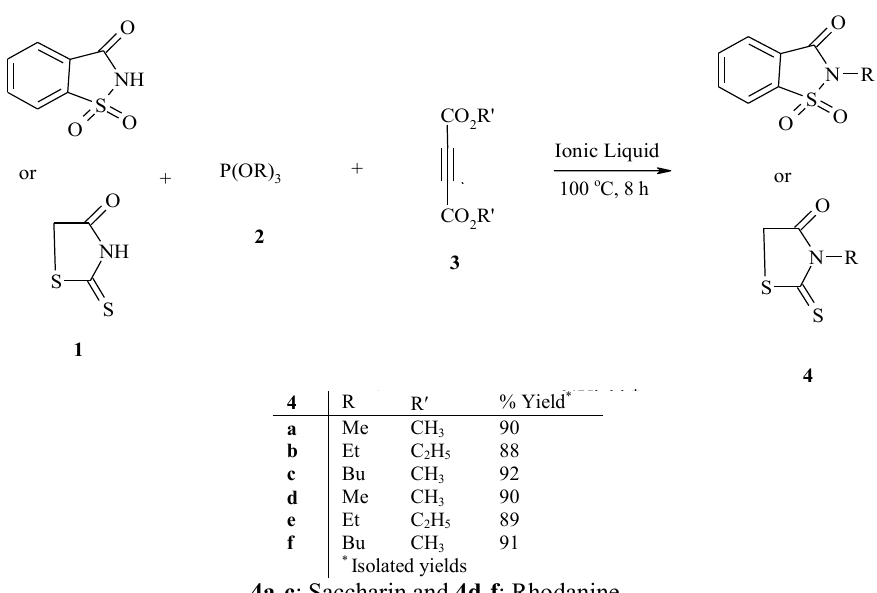
Figure 1. N Alkylation of saccharin or rhodanine with trialkyl phosphites in the presence of dialkyl acetylenedicarboxylate in ILs as solvent.